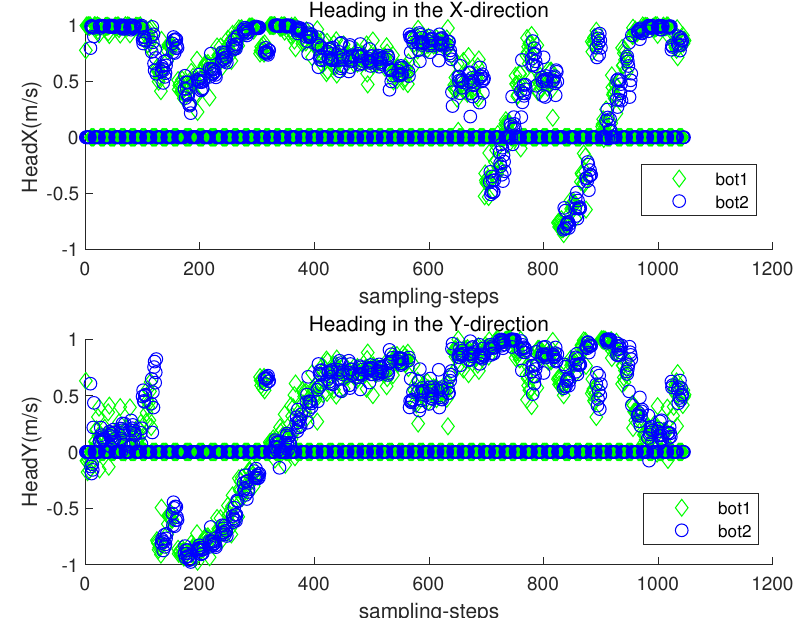
Figure 15. Scenario 3. head x and head y with respect to